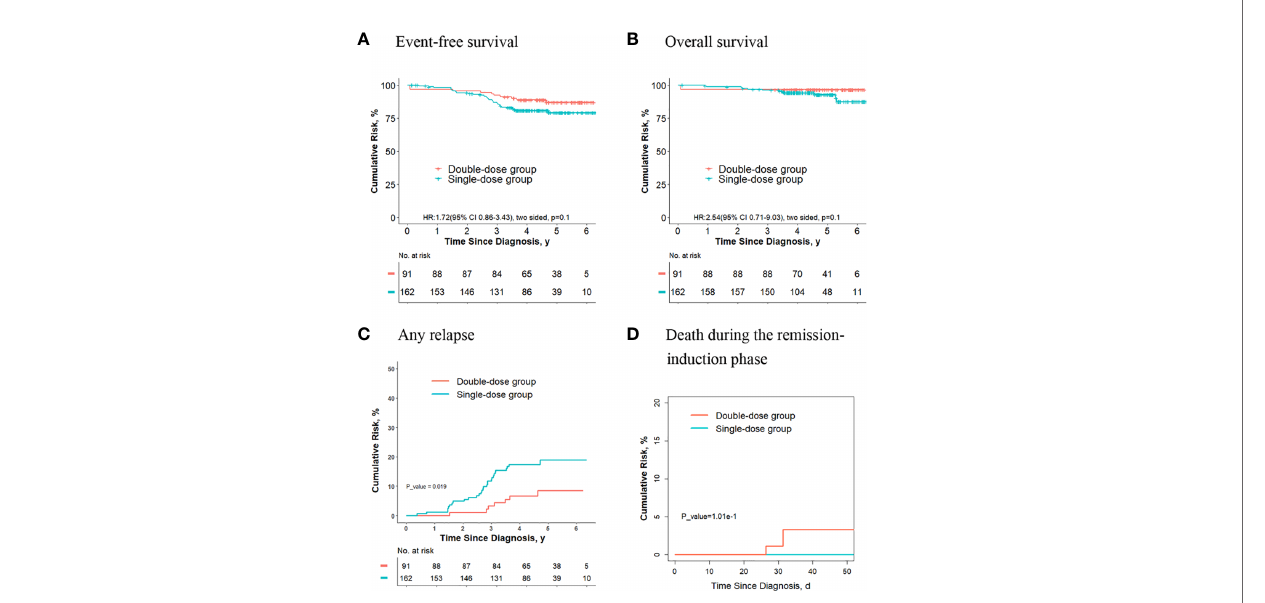
FIGURE 7 | Analysis of survival and cumulative risk of relapse and early death for fi nal low-risk patients without ETV6-RUNX1 positivity or hyperdiploidy ALL and didn ’ t meet the criteria for the second dose of